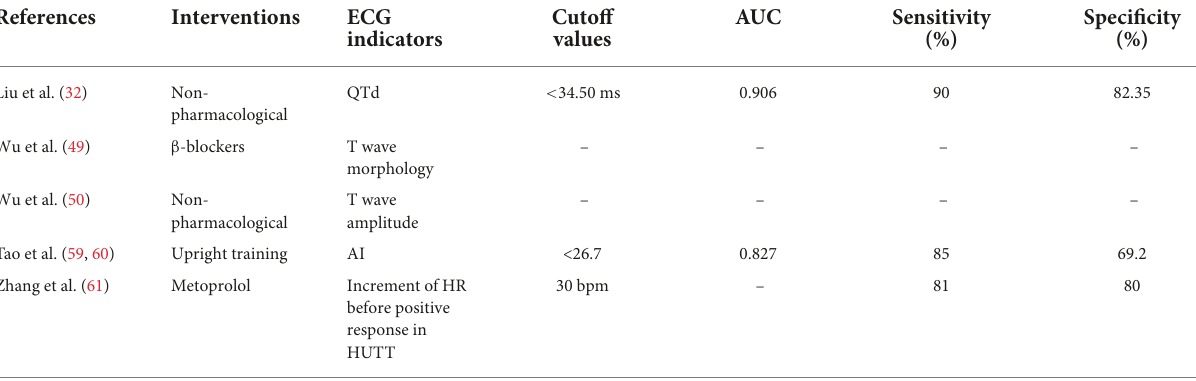
TABLE 3 Predictors of individualized treatment of pediatric